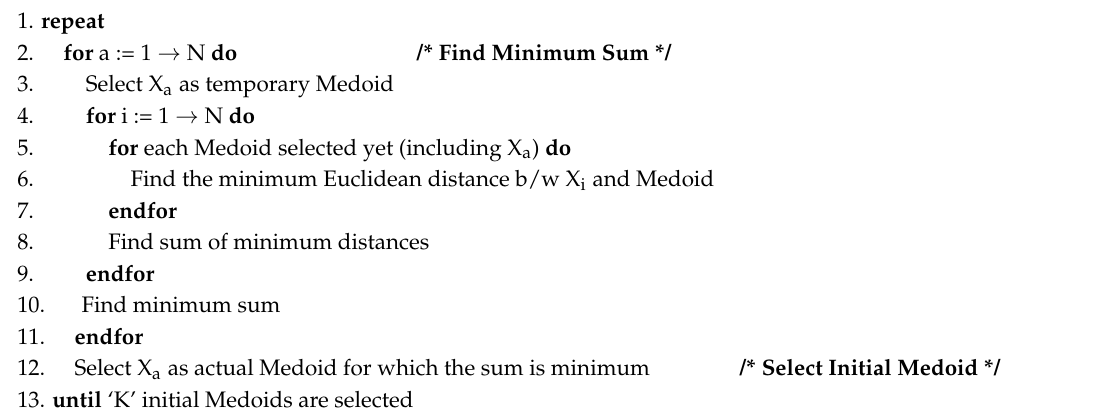
Algorithm 2. Pseudo-code of the Build Phase